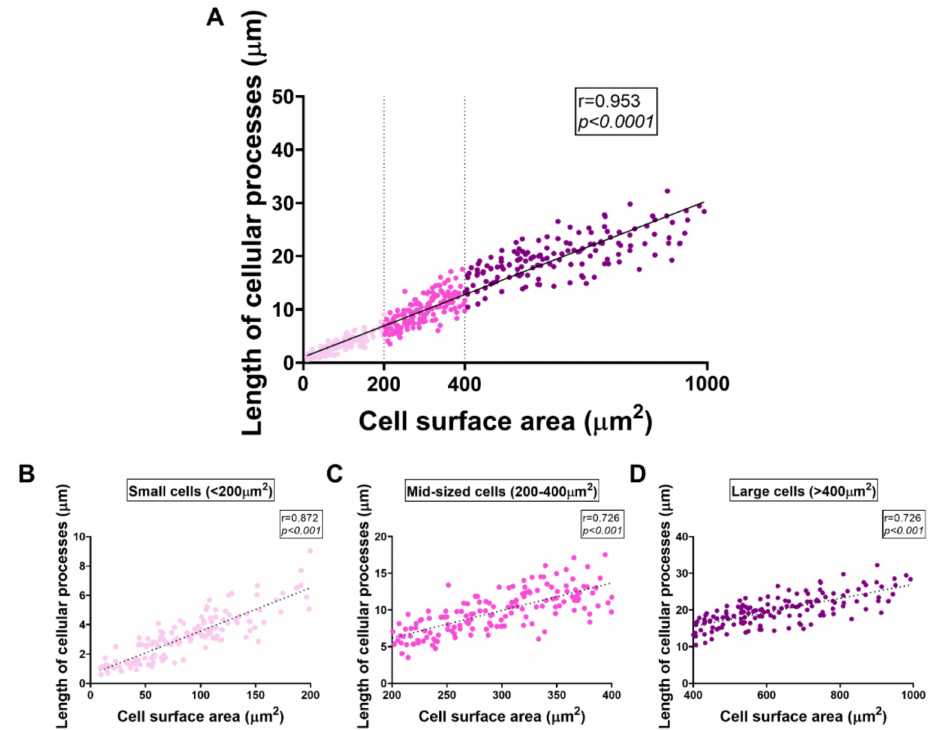
Figure 8. Correlation between cell surface area and length of cellular processes. BV2 cells plated at 5 × 10 5 in 25 cm 2 flasks were starved with 1% FGM for 24 h prior to treatment with 10% FGM (control), 1.0 µ g/mL LPS, 1.0 µ g/mL LPS + PACAP 100 nM and 1.0 µ g/mL LPS + VIP 100 nM for 24 h; then, images were captured using Nikon Eclipse Ts2 inverted microscope. Images were assigned performed using Image J 1.51 (NIH) software. The average length of cellular processes (expressed in µ m) was obtained by averaging the measurements of 2–3 processes × cell. ( A ) Correlation between cell surface area and the length of cellular processes. Regression analyses showing significant correla- tions between cell surface area and length of cellular processes both in ( B ) small cells (<200 µ m 2 ), ( C ) mid-sized cells (200–400 µ m 2 ) and ( D ) large cells (>400 µ m 2